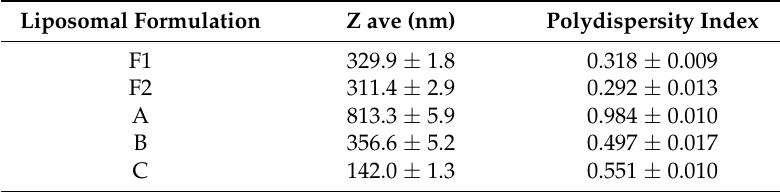
Table 3. Particle size and size distribution of griseofulvin-loaded liposomes prepared by various techniques (Mean ± SEM, n = 18).